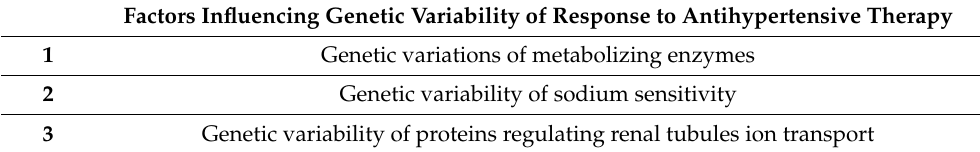
Table 1. Factors influencing genetic variability of response to antihypertensive therapy.